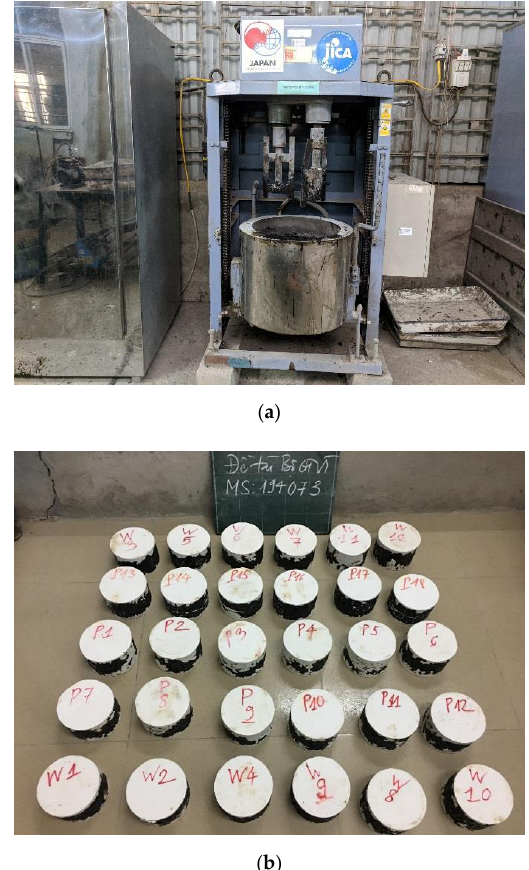
Figure 2. The SMA samples preparation and testing: ( a ) Asphalt mixer, ( b ) The SMA and HMA samples.